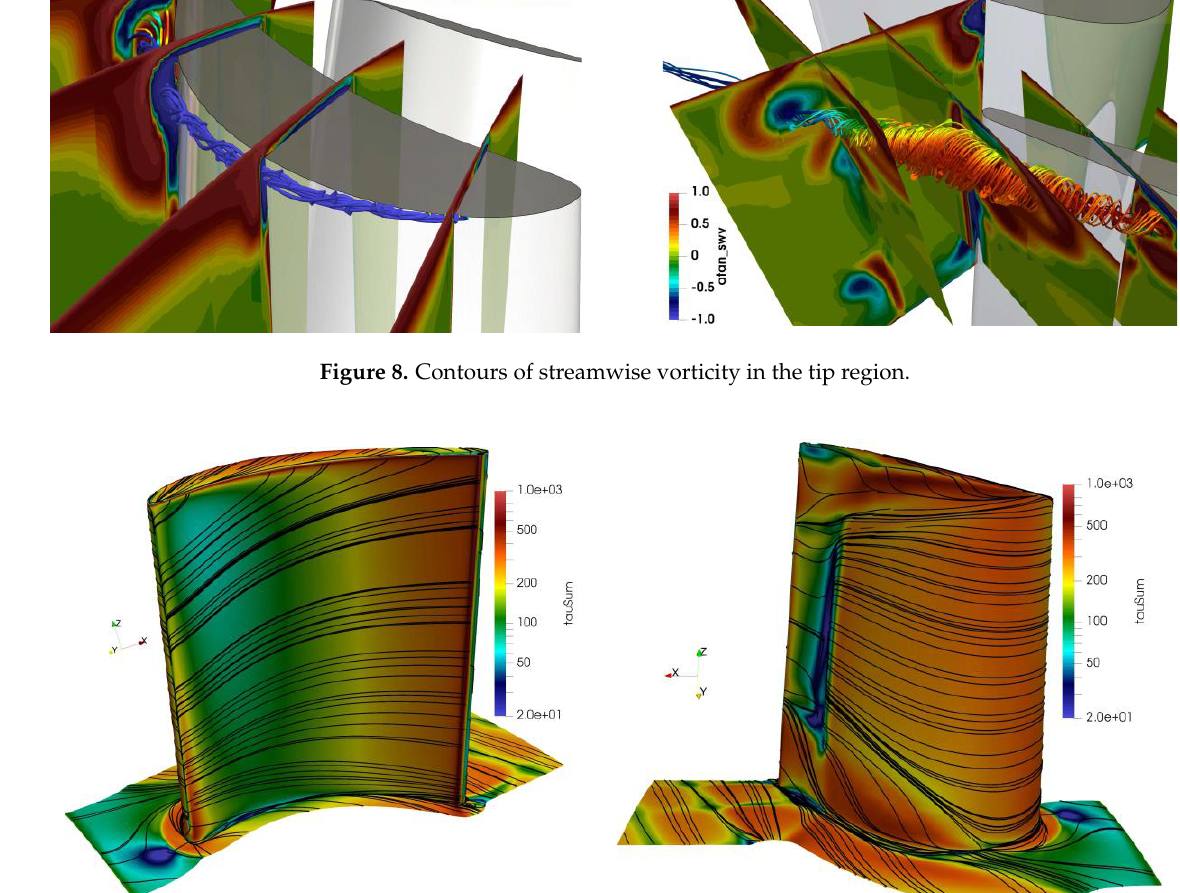
Figure 9. Wall shear stresses and streamlines on rotor blade pressure and suction side.